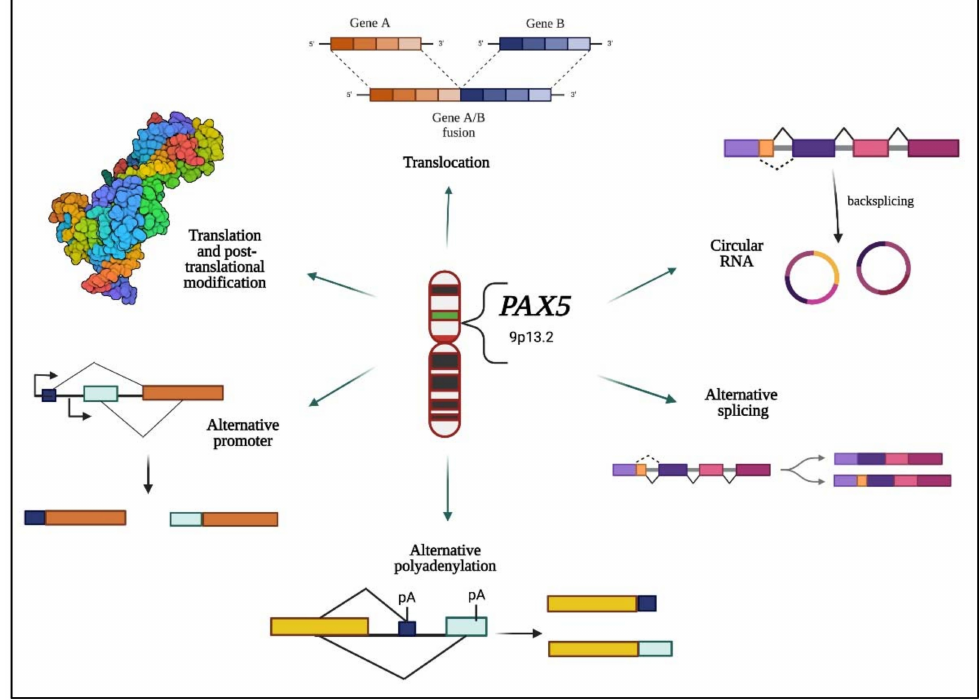
Figure 1. Hallmarks of PAX5 gene alterations and expressed products. This schematic illustration represents the reported modifications of the PAX5 gene sequence and expressed products. Multiple studies indicate that the human PAX5 gene undergoes various alterations that affect its spatiotemporal expression to function as an oncogene or tumor suppressor. Specifically (clockwise from the top), the PAX5 locus can undergo: genetic translocations resulting in chimeric fusion proteins and alternative promoter regulation [7–11]; transcriptional back-splicing resulting in circular PAX5 RNAs [12–14]; transcriptional alternative splicing of coding exons [15–17]; alternative use of poly-adenylation (pA) termination signals [18]; use of alternative promoter regions and transcription initiation sites [11]; and post-translational modifications, which impact its transactivation potential